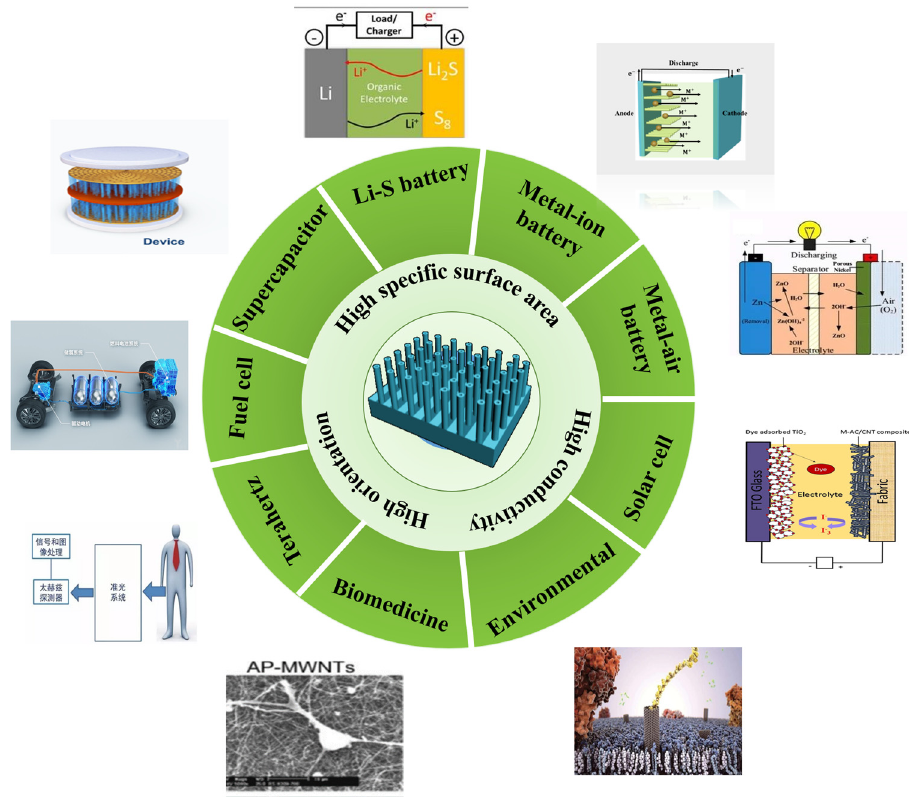
Figure 1: An overview of VACNT - based materials with excellent performance for advanced devices and their potential application in di ff erent fi elds. The insertion diagram in the middle is a VACNTs array. Copyright 2014, American Chemical Society.